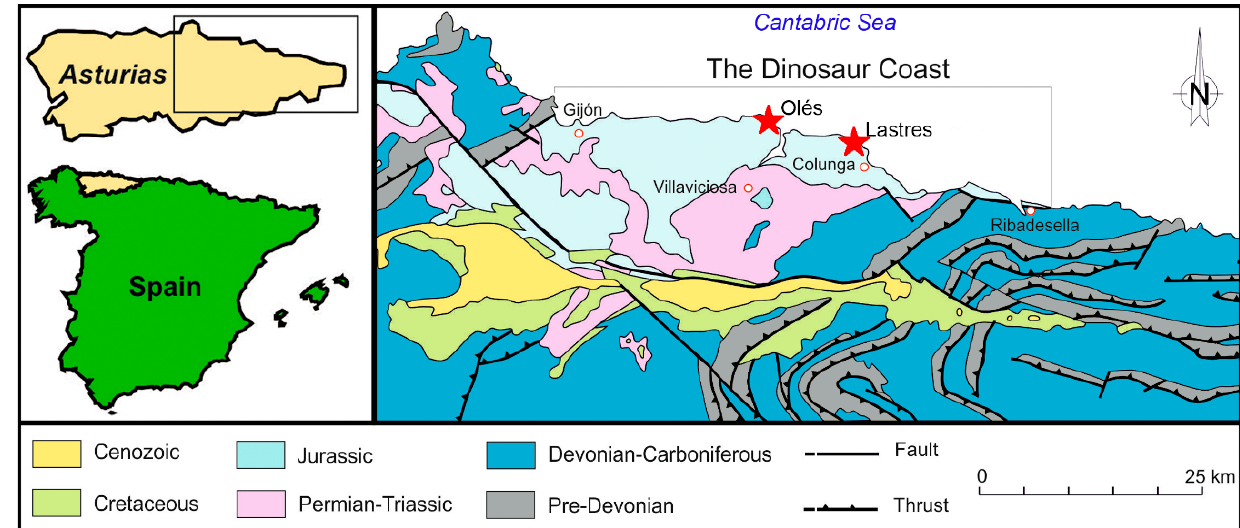
Figure 1. Geological and geographical map from the Asturias coast. The studied locations (Oles and Lastres) are indicated with red stars.